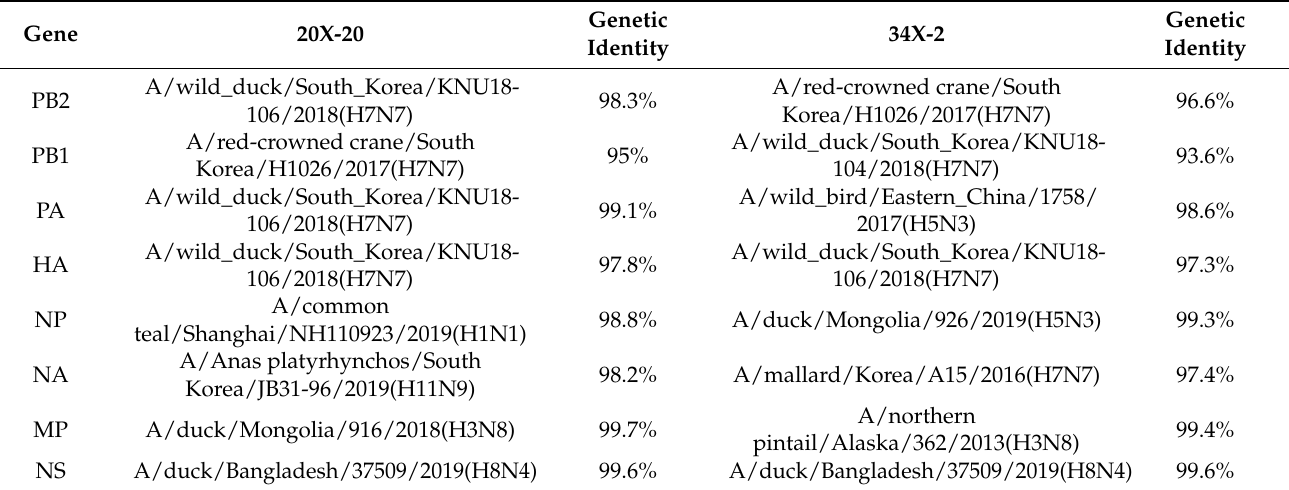
Table 2. Sequence identities of the A/mallard/South Korea/JB20X-20/2021 (20X-20) and A/mallard/South Korea/JB34X- 2/2021 (34X-2)